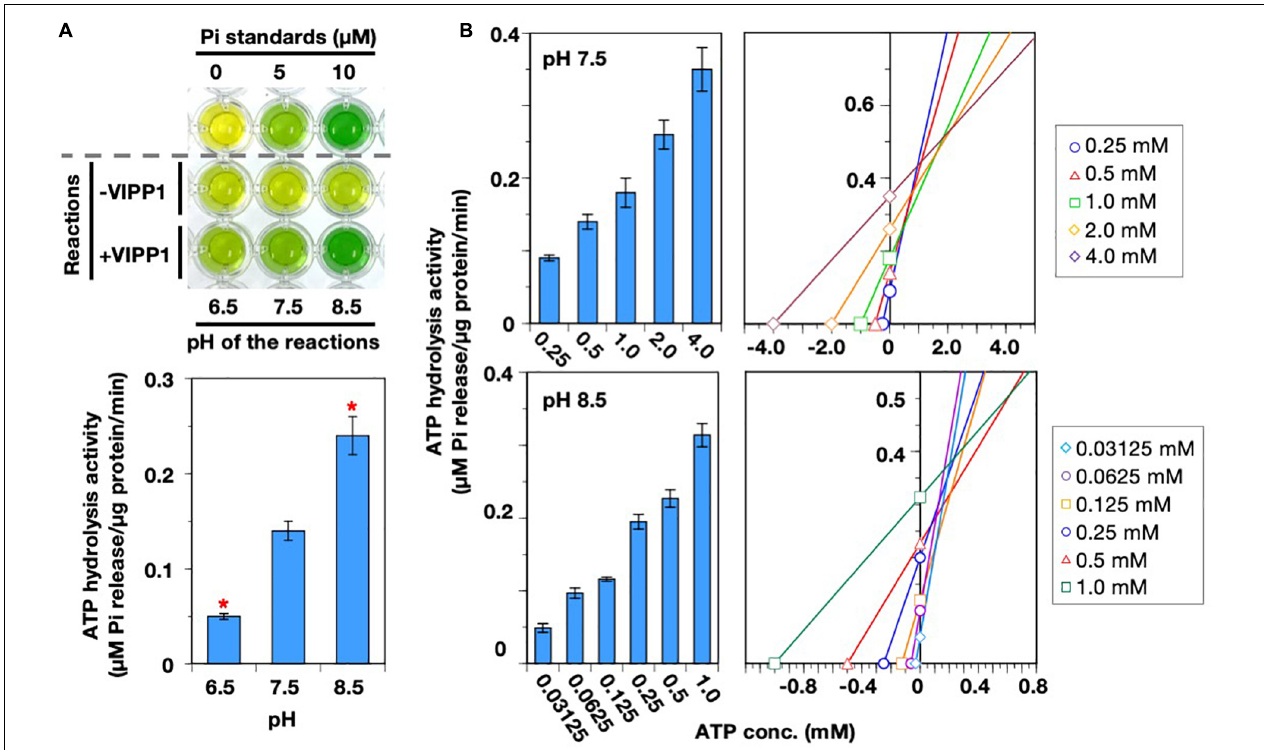
FIGURE 5 | Properties of the Ca 2 + -dependent ATP hydrolysis. (A) A photograph of typical results of a malachite green-based assay (upper panel) and the quantified activity of ATP hydrolysis (lower panel) in the presence of Ca 2 + . The reactions were carried out at pH levels (6.5, 7.5, and 8.5). Asterisks in the bar graph denote significant differences from the activity at pH 7.5 (Welch’s t -test with p < 0.01). (B) Analyses for V max and K M for ATP hydrolysis activity in the presence of Ca 2 + at pH 7.5 and 8.5. ATP hydrolysis activity was measured in the presence of various ATP concentrations, which are indicated at the bottom of the bar graphs. Each bar graph and error bar represents the means and SD, respectively, of results from 5–9 independent experiments (left graphs). The concentration of ATP and the average of VIPP1-dependent Pi release are plotted on the graph in accordance with the Cornish–Bowden plot method. The X and Y values of the intersection point represent K M and V max , respectively (right